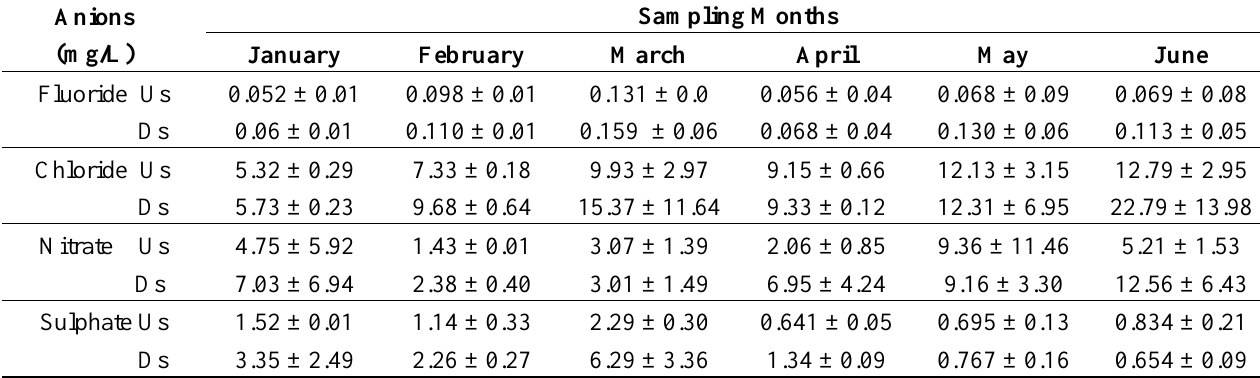
Table 3. Average anion concentrations upstream (Us) and downstream (Ds) of Mvudi